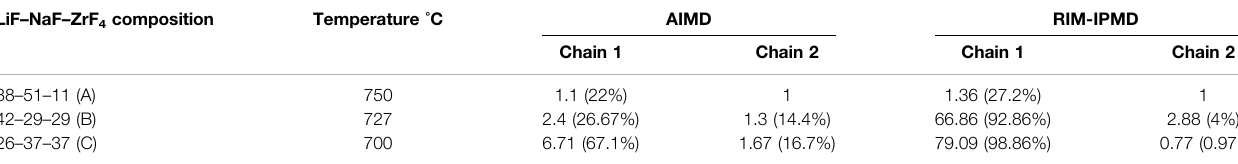
TABLE 3 | % of Zr involved in fl urozirconate chain formation as calculated by AIMD and RIM-IPMD. LiF – NaF – ZrF 4